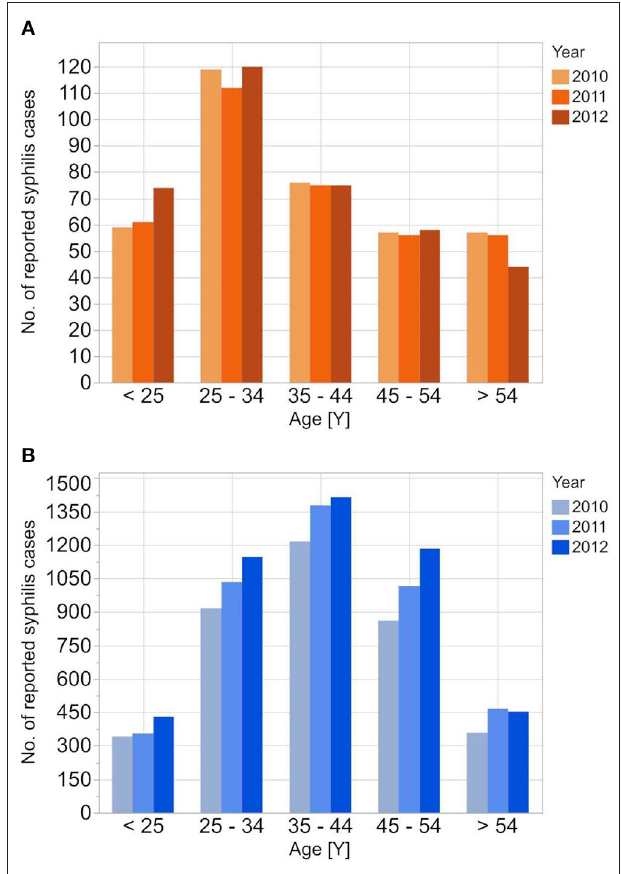
FIGURE 1 | Age stratified reported incidences of syphilis reported to RKI from 2010 to 2012 for the female (A) and the male (B) population.